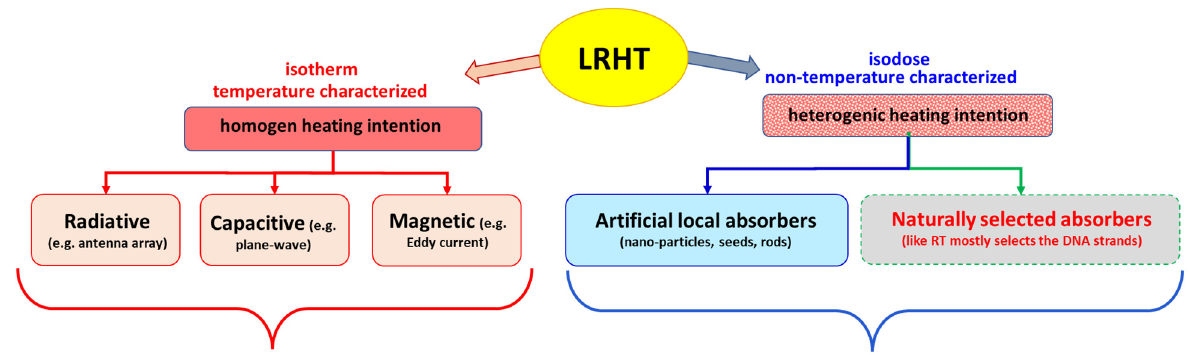
Figure 1. The two essential branches of electromagnetic LRHT methods. The majority of applications use the conventional focusing with isothermal intention. The method requests to measure the temperature as dose characterization. Heterogeneous (non-isothermal) heating is an emerging category of LRHT applications with nanoparticle insertion (mainly magnetic suspension). The heterogenic heating methods do not need direct temperature measurement. The dose measures the absorbed energy (J/kg = Ws/kg), so the tumor’s temperature develops by the heat-conduction from the targeted particles. The figure does not show the popular non-electromagnetic LRHT methods (e.g., HIPEC and HiFu).